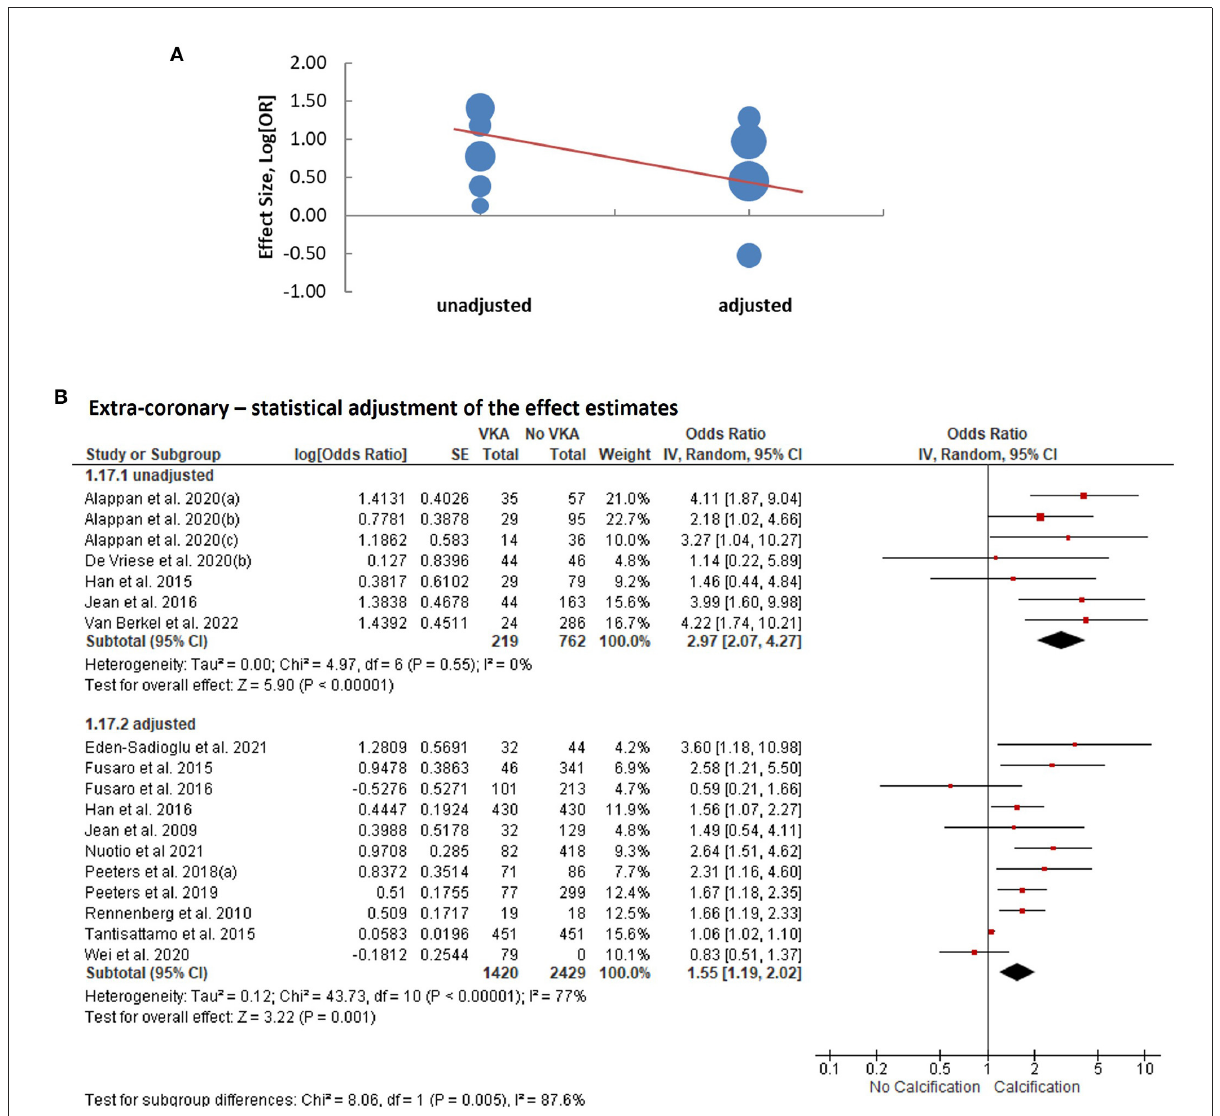
FIGURE5 Analysis of extra-coronary arterial calcification according to statistical adjustment for confounding variables. (A) Meta-regression of the effect sizes—adjusted vs. unadjusted. (B) Subgroup analysis based on whether or not statistical adjustments were applied to calculate the effect